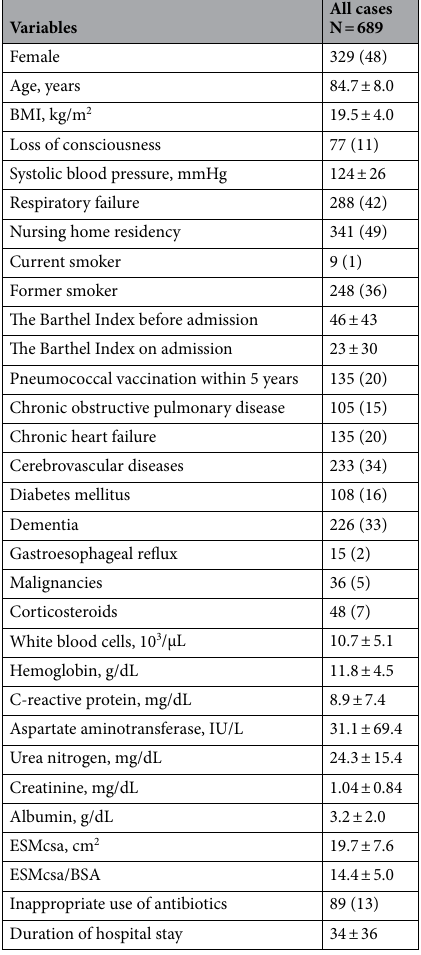
Table 1. Baseline characteristics of patients. Data are presented as the number (%) or mean ± SD. BMI body mass index, BSA body surface area, ESM erector spinae muscle, ESMcsa cross-sectional area of ESM, n number, SD standard